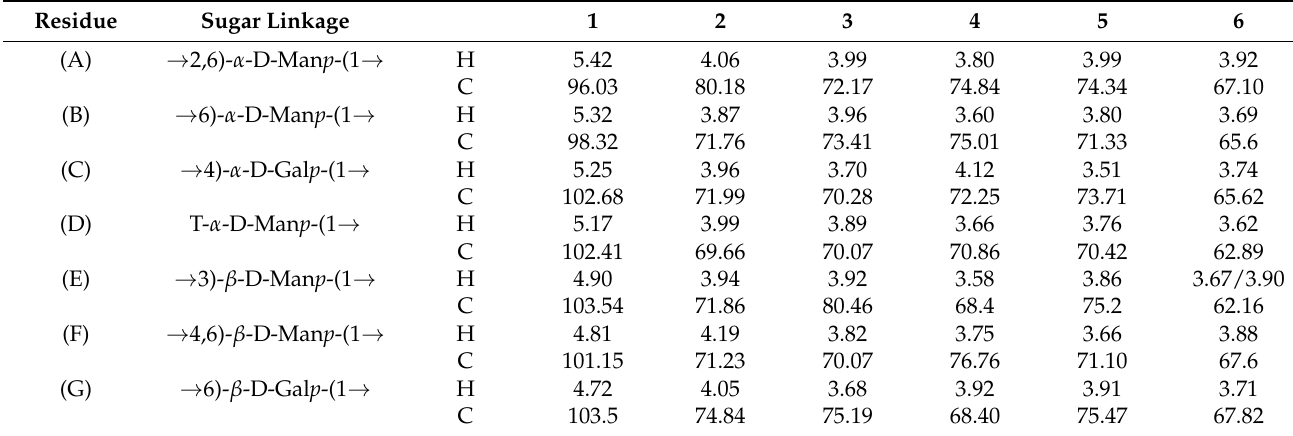
Table 2. 1 H and 13 C NMR spectrum assignments for S2 (ppm).